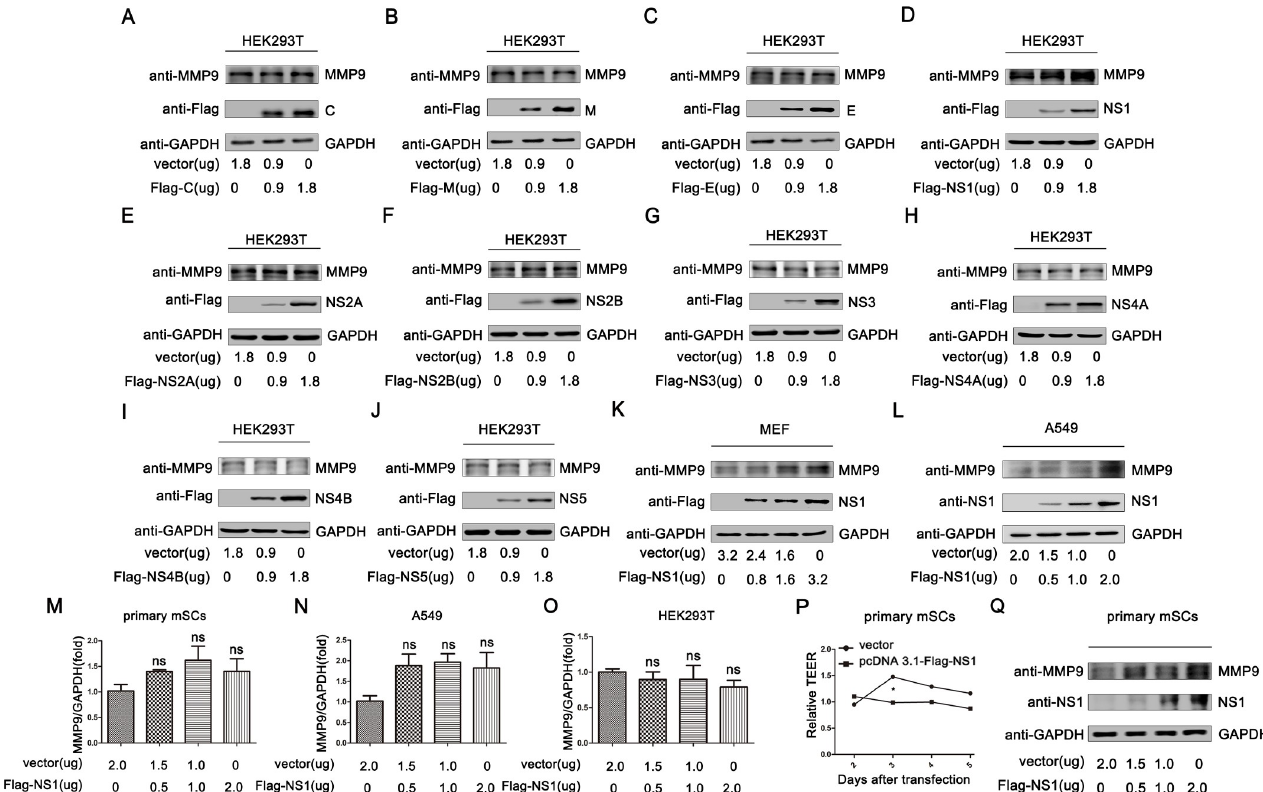
Fig 4. MMP9 was upregulated by ZIKV NS1 on protein level. (A – J) HEK293T cells were transfected with pcDNA3.1(+)-Flag-C, -M, -E, -NS1, -NS2A, -NS2B, -NS3, -NS4A, -NS4B, or -NS5 using a concentration gradient for 48h. Total MMP9, C, M, E, NS1, NS2A, NS2B, NS3, NS4A, NS4B, NS5, and GAPDH levels in whole cell lysates (WCLs) were determined by western blotting with the indicated antibodies. MEFs ( K) and A549 cells (L) were transfected with different concentrations of pcDNA3.1(+)-Flag-NS1. After 48h post tranfection total MMP9, NS1, and GAPDH proteins expressed in WCLs were detected by western blotting with the indicated antibodies. (M – O) Different concentrations of pcDNA3.1(+)-Flag-NS1 were transfected into primary mSCs ( M ), A549 cells ( N ), and HEK293T cells ( O ). After 48h post tranfection, MMP9 mRNA levels were measured by qRT-PCR. Data are expressed as means ± SEMs of three independent experiments. ns, not significant (one-way ANOVA). ( P ) Primary mSCs were transfected with empty vector or pcDNA3.1(+)-Flag-NS1, and resistance values were examined from day 2 after transfection. Data are expressed as means ± SEMs of three independent experiments. � P < 0.05. ns, not significant (two-way ANOVA). ( Q ) Primary mSCs were transfected with empty vector or pcDNA3.1(+)-Flag-NS1, and the expression of NS1 and MMP9 was measured by western